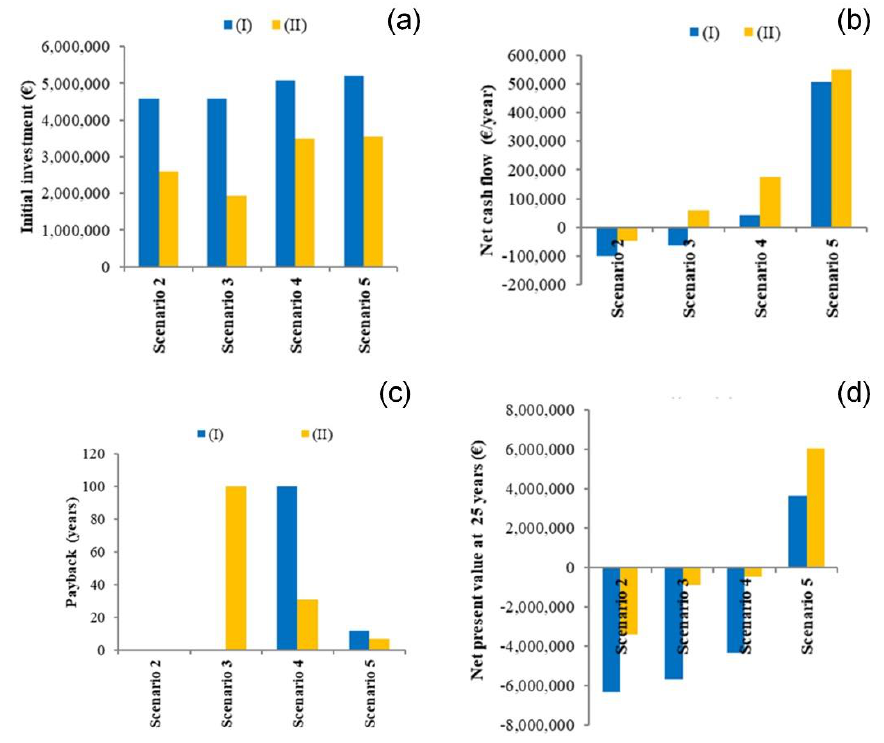
Figure 4. Economic balance and feasibility analysis for Cases I and II. ( a ) Initial investment. ( b ) Net annual cash flow. ( c ) Payback. ( d ) Net present value (NPV) at 25 years. The payback period for Scenarios 2 and 3 is not represented because the net annual cash flow was negative for these scenarios.